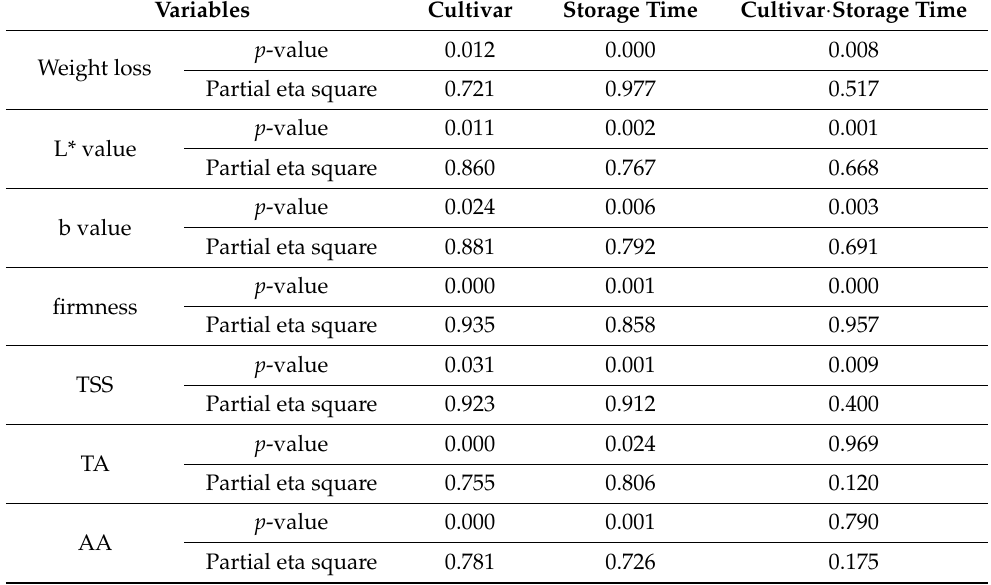
Figure 1. Changes in weight loss rate in freshly cut pineapple during storage. Different capital letters (A–C) indicate significant ( p < 0.05) differences in weight loss rates between varieties at the same storage time; different lowercase letters (a–f) indicate significant ( p < 0.05) differences in weight loss rates between the same varieties at different storage times. Table 2. Main and interactive effects of variety and storage time on quality attributes of fresh-cut